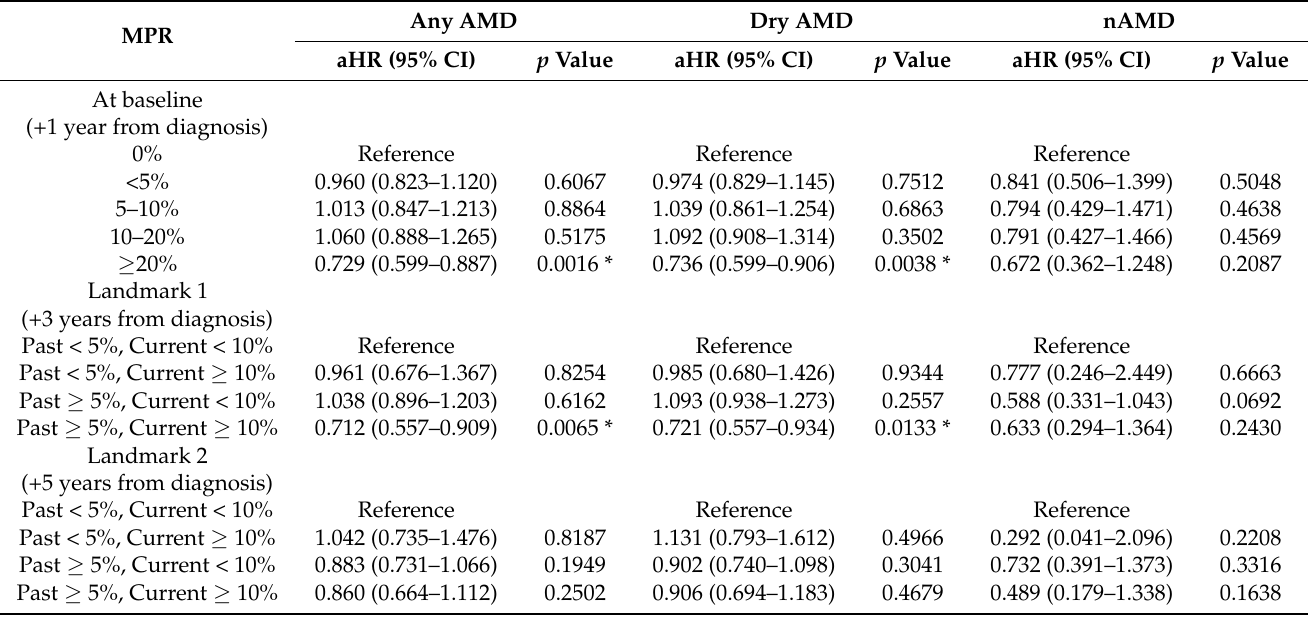
Table 6. Time varying and dosage of fibrate on risk of any